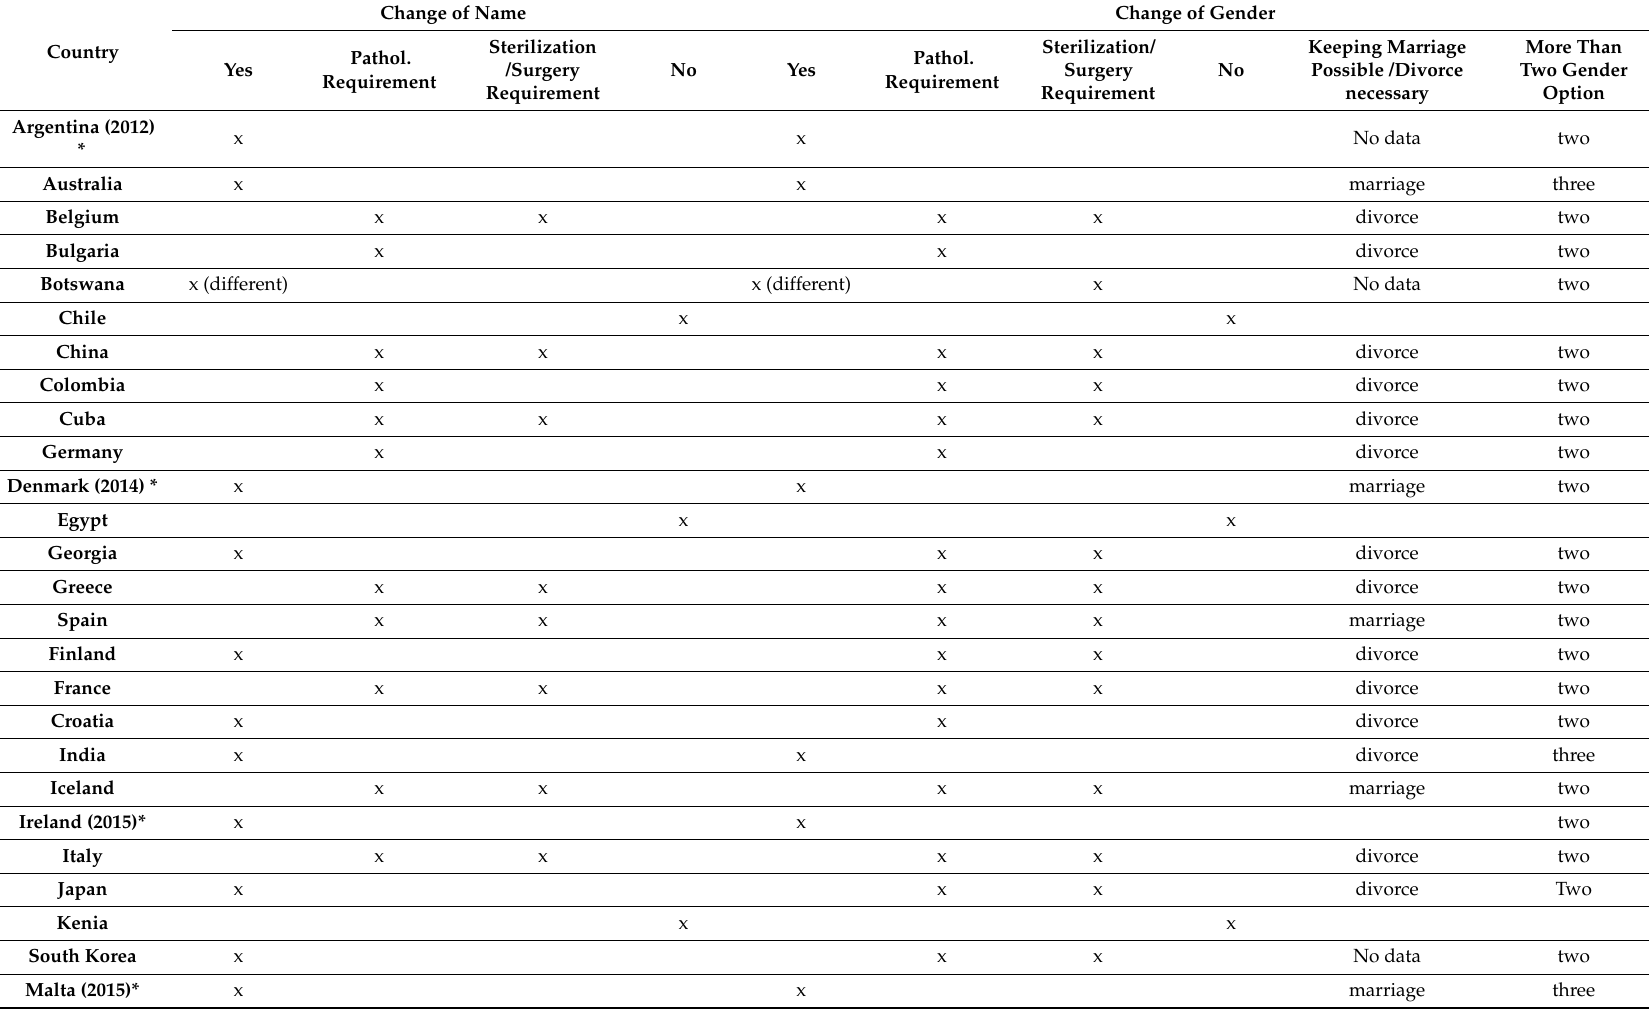
Table 3. The current worldwide situation for legal gender recognition (extracting from